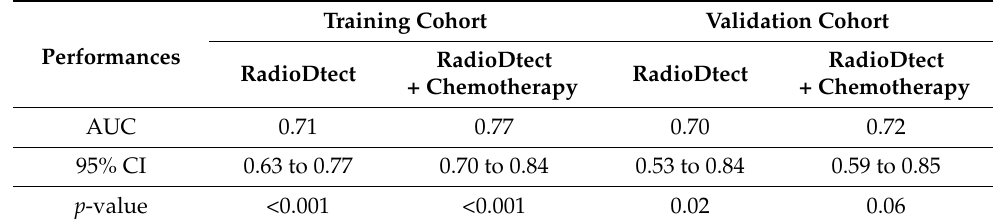
Table 3. Result on performance of RadioDtect and combined RadioDtect + chemotherapy approach for Grade ≥2 toxicities.